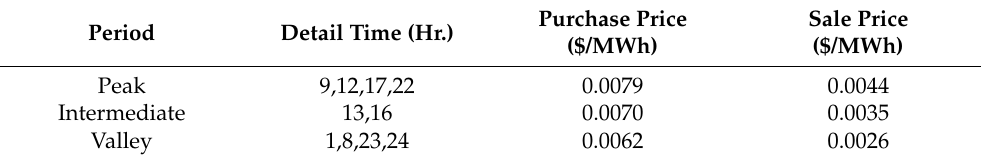
Figure 16. Convergence characteristics of the MOBWO algorithm for Case III. Table 9. Comparison of emissions with different techniques.